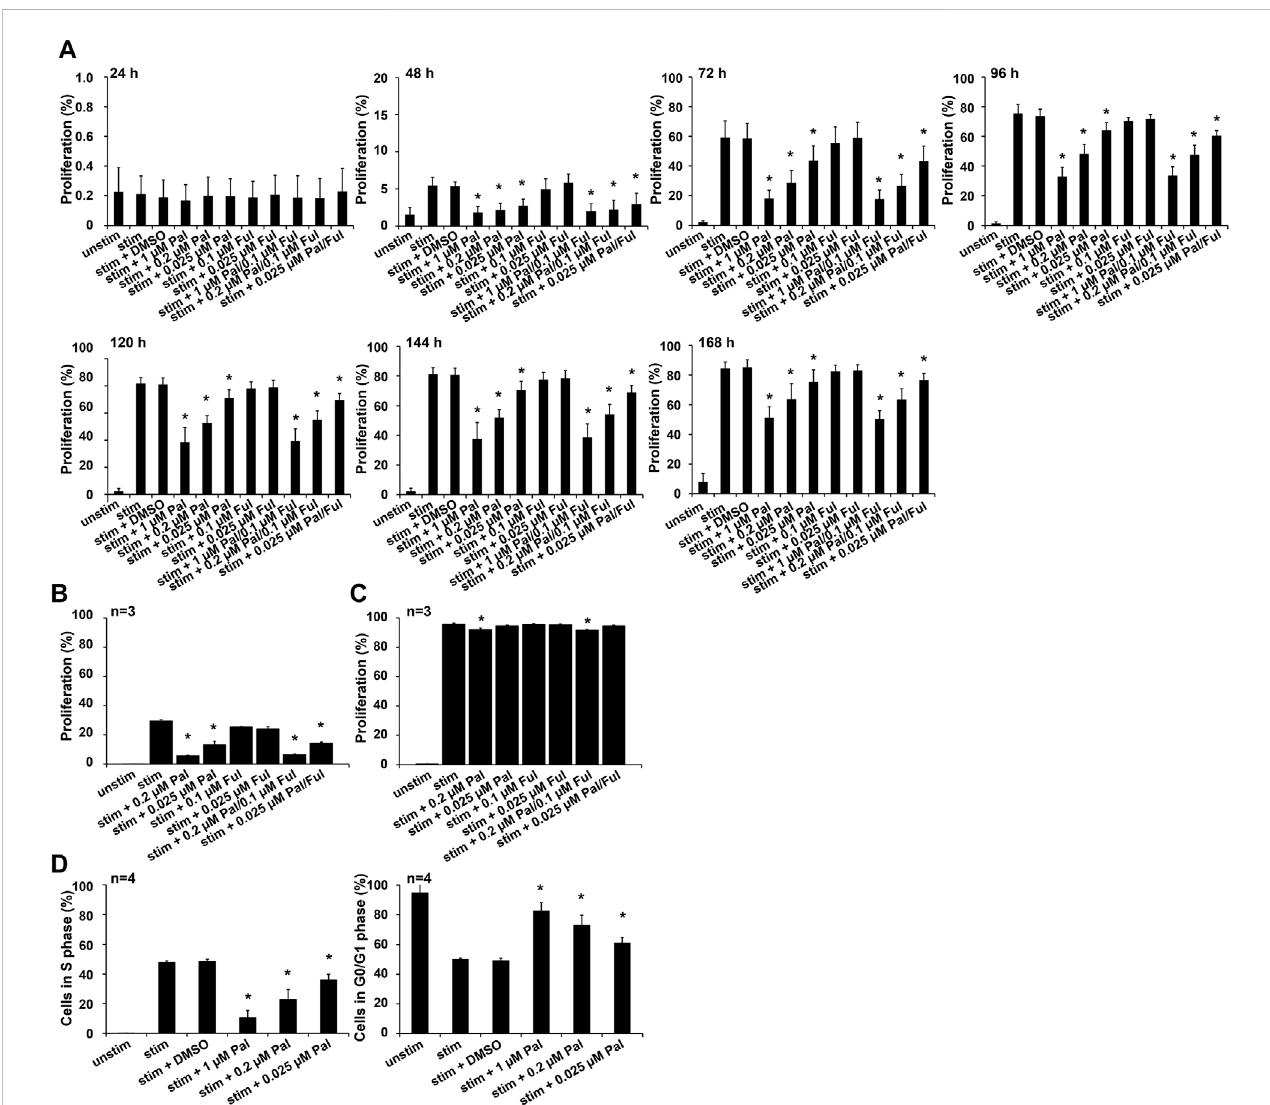
In fl uence of palbociclib and fulvestrant on T cell proliferation. (A) eFluor ™ 670-stained T cells were stimulated by anti-CD3/CD28 beads and cultured in the presence or absence of palbociclib (daily addition), fulvestrant, or their combination at indicated concentrations for 24, 48, 72, 96, 120, 144, and 168 h. Cells were harvested and dilution of eFluor670 ™ dye was determined by fl ow cytometry. The results are depicted as the means ± SEM of four donors. (* p ≤ 0.05 compared to control sample “ stim + DMSO ” ). (B,C) eFluor ™ 670-stained T cells were stimulated by anti-CD3/CD28 beads and cultured in the presence or absence of palbociclib (single administration), fulvestrant, or their combination for (B) 48 h and (C) 120 h. Cells were harvested and dilution of proliferation dye eFluor670 ™ was determined by fl ow cytometry. The results are depicted as the means ± SEM of three donors. (* p ≤ 0.05 compared to control sample “ stim ” ). (D) DNA replication in proliferating cells was analyzed by EdU fl ow cytometry assay. Therefore, T cells were stimulated by anti-CD3/ CD28 beadsandcultured inthepresence ofpalbociclib(dailyaddition) atindicatedconcentrations for96 h.18 hprior tocell harvesting, cellswereincubated with10 µMEdU.CellswereharvestedandpercentageofEdU-positivecellswasdeterminedby fl owcytometry.(* p ≤ 0.05comparedtocontrolsample “ stim+ DMSO ”